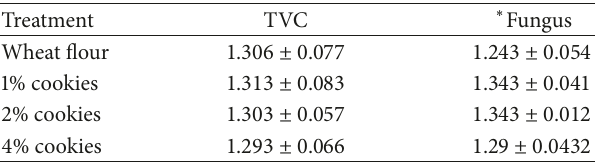
Table 4: Microbiological qualities of control wheat flour and 𝛽 - glucan incorporated cookies.